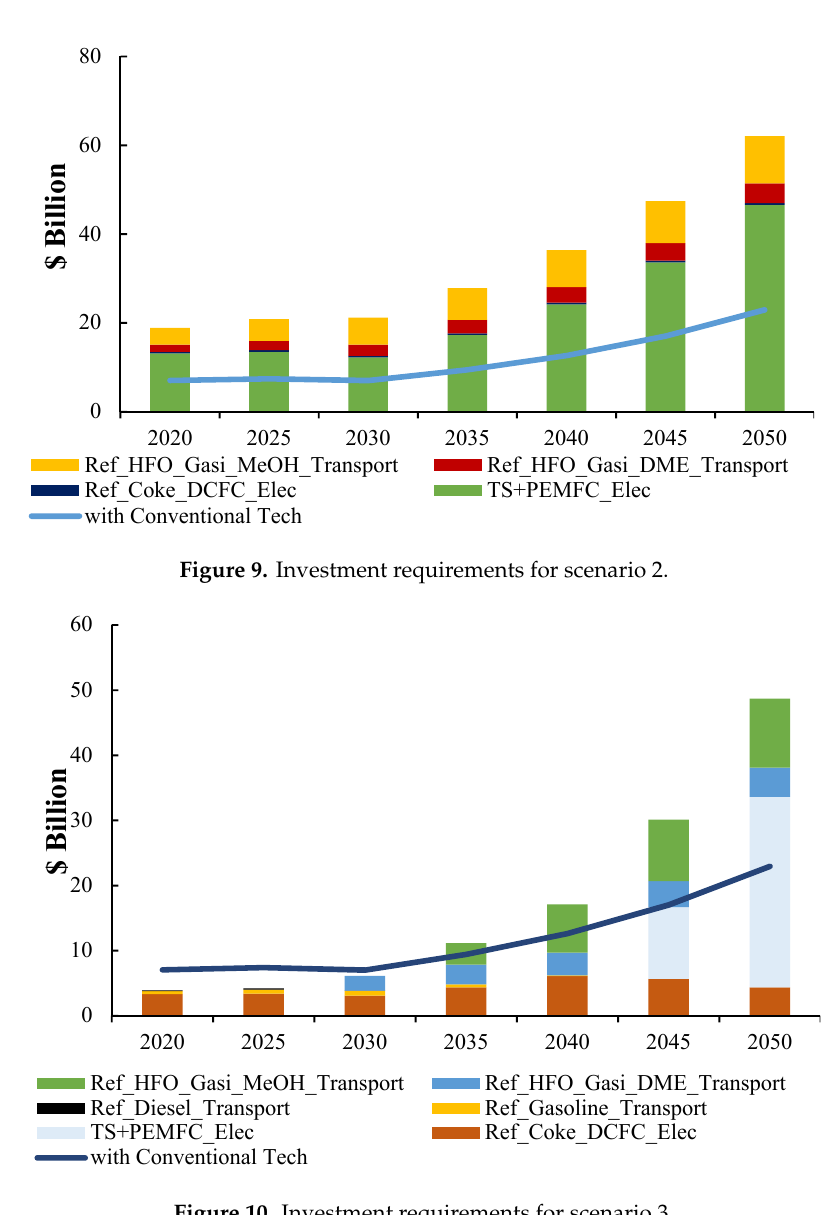
Figure 10. Investment requirements for scenario 3.